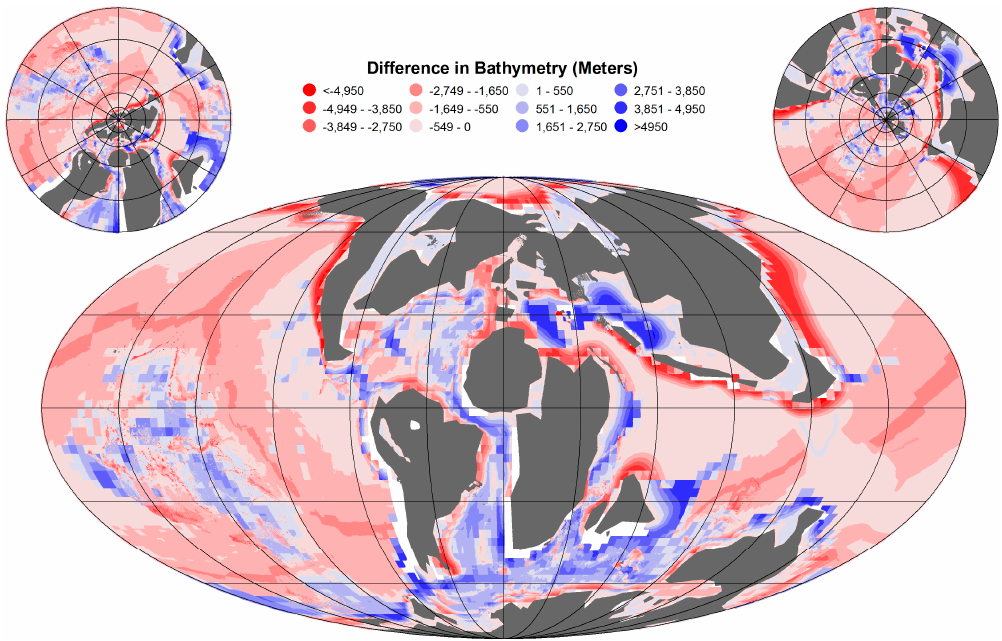
Figure 11. Difference map between the SW07 and OES C–T reconstructions.